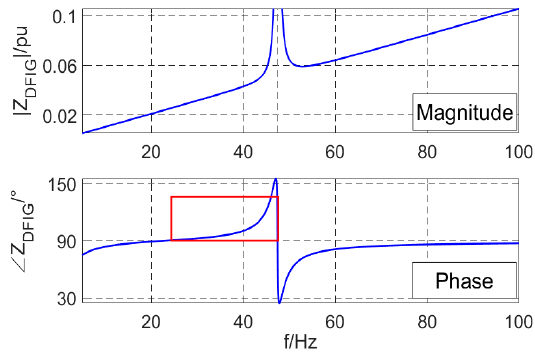
Figure 5. Impedance–frequency characteristic of a doubly-fed induction generator (DFIG) wind generator.